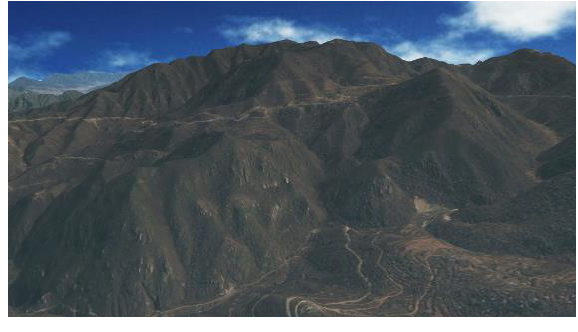
Figure 2 . Terrain scene.